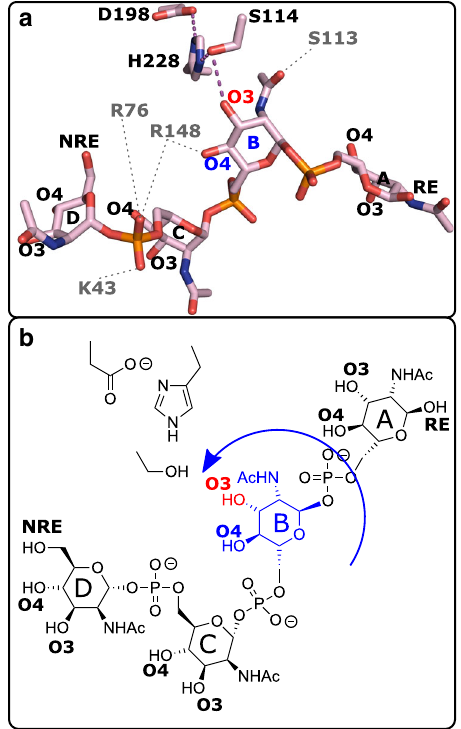
Fig. 6 Orientation of CPS-DP4 rings A – D. Crystal structure of wild-type CsaC soaked with CPS-DP4 ( a ) and schematic representation ( b ). O3 (red) of ring B (blue) is in physical proximity to the catalytic triad serine 114, while O4 protrudes away from the active site. Hydrogen bond (dashed magenta lines) distances are ≤ 3.2 Å. Gray dashed lines indicate coordination by amino acid residues depicted in gray single-letter code. Amino acid residues of the catalytic triad are labeled in